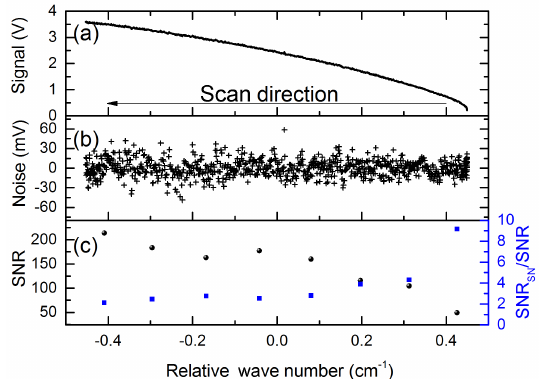
Figure 5. (a) Heterodyne signal change throughout the LO fre- quency scan (current tuning) using a 1373K blackbody as a source; (b) heterodyne signal noise over the laser tuning; (c) evo- lution of the LHR SNR computed on successive chunks of 100 data points. SNR SN / SNR depicts the ratio of the theoretically calcu- lated shot-noise-limited SNR (Eq. 10) over the measured